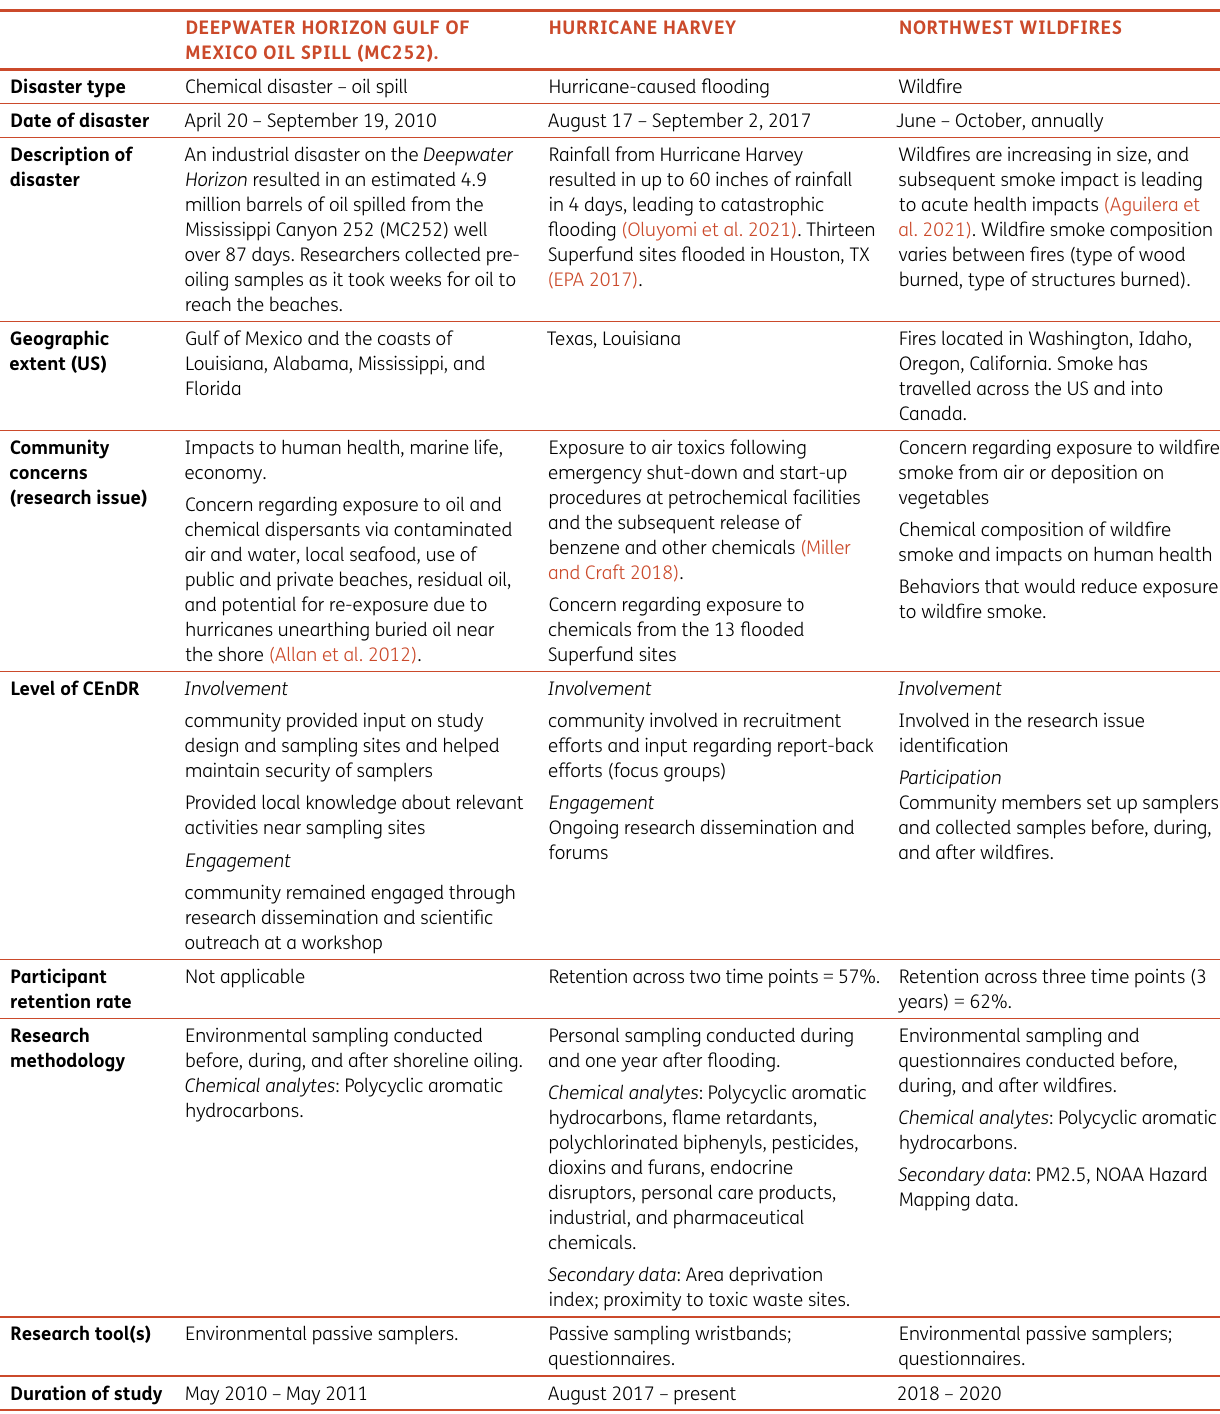
Table 1 Description of case studies, community concerns following the disaster, level of community-engaged disaster research (CEnDR), and description of the research methodology and tools